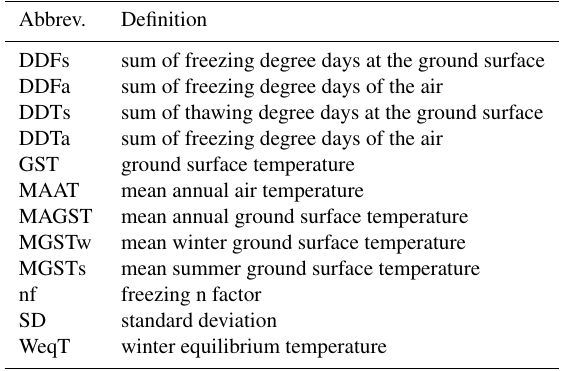
Table 1. Abbreviations used in this paper.